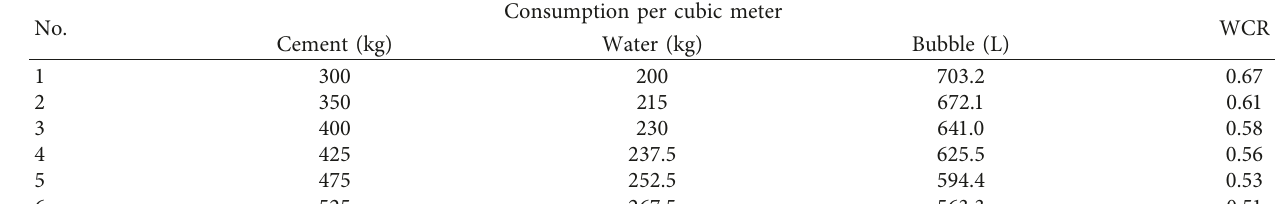
Table 3: Mix proportions of laboratory test.